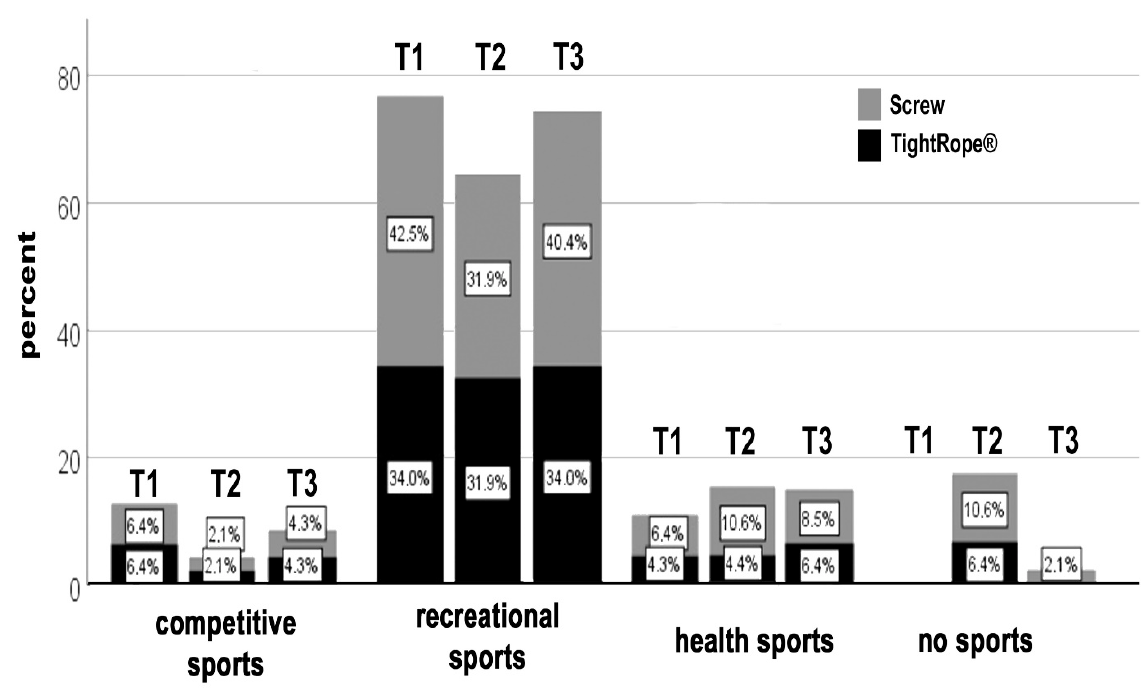
Figure 3. Sports ability and exercise sports level of the screw fixation group and the knotless Tight- ® fixation group at the three examination Rope ® fixation group at the three examination times. TightRope